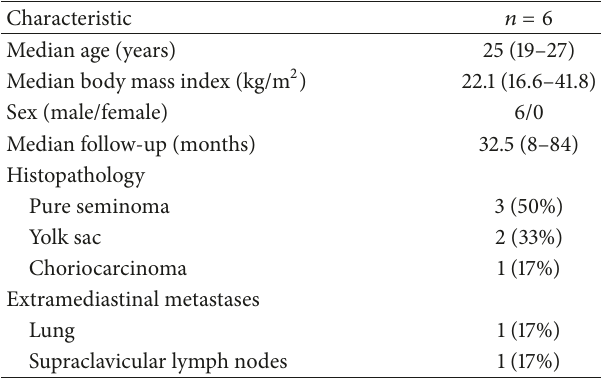
Table 1: Characteristics of the six patients with primary mediastinal germ cell